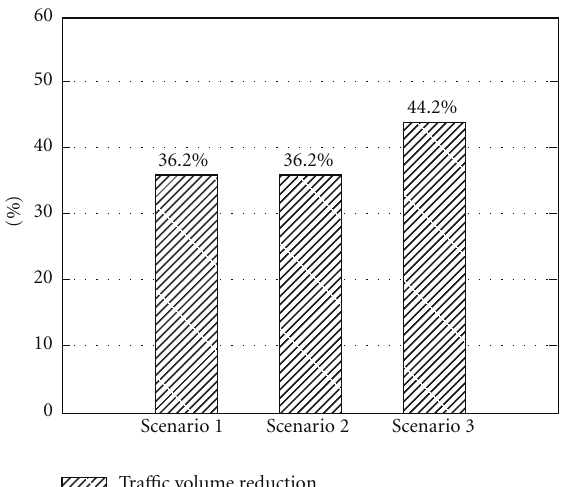
Figure 5: Hit rate—based on reference scenario.